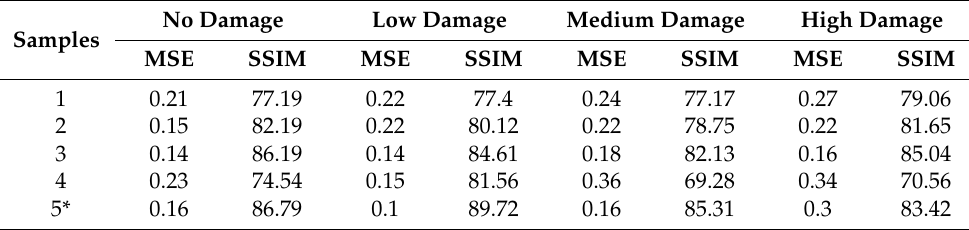
Table 20. Sampling of images with a slight difference in results for five images per class. Samples